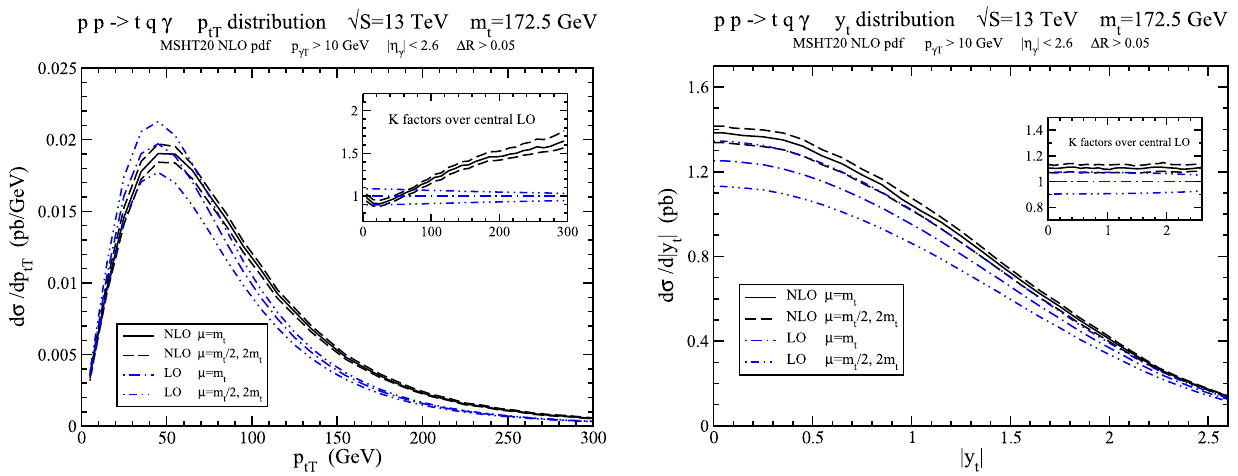
Fig. 3 The LO and NLO top-quark p T (left) and rapidity (right) distributions in tq γ production at 13 TeV LHC energy